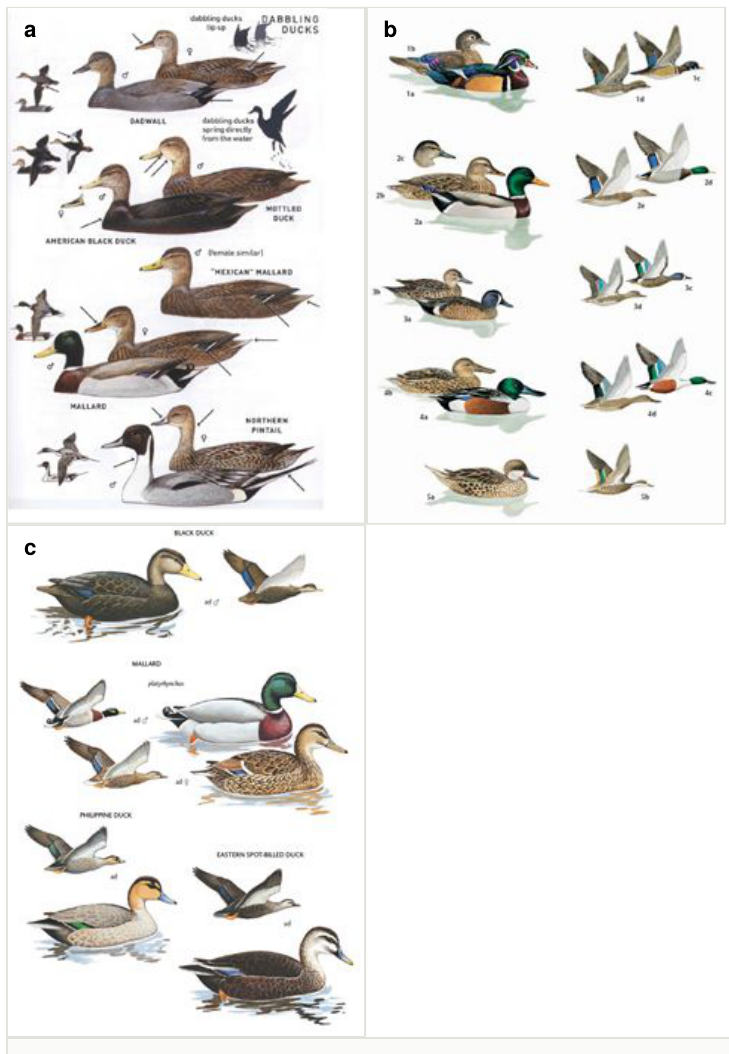
Color plates from fi eld guides to birds (Aves). Note repeated depictions of di ff erent sexes and